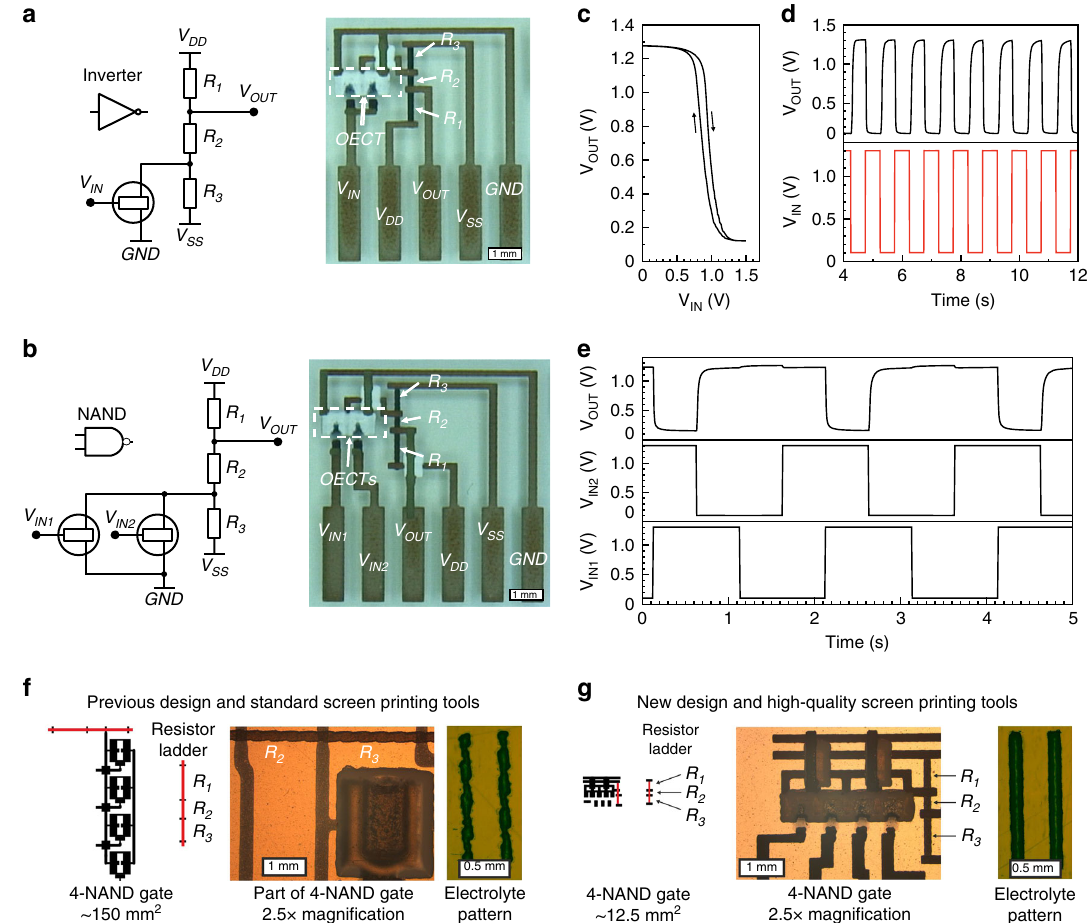
Fig. 3 Logic gates based on printed electrochemical transistors. Schematics of an inverter ( a ) and a two-input NAND gate ( b ) based on OECTs, together with the corresponding optical images (scale bar: 1 mm). The supply voltages V DD and V SS were + 5 V and − 5 V, respectively. c Voltage transfer characteristics and d switching characteristics of the inverter, where the propagation delay t p = 54 ms. e Characterization of the two-input NAND gate, where the propagation delay t p = 20 ms. f A four-input NAND gate according to the previous design (ref. 39 ) requires an area of ~150 mm 2 , partially